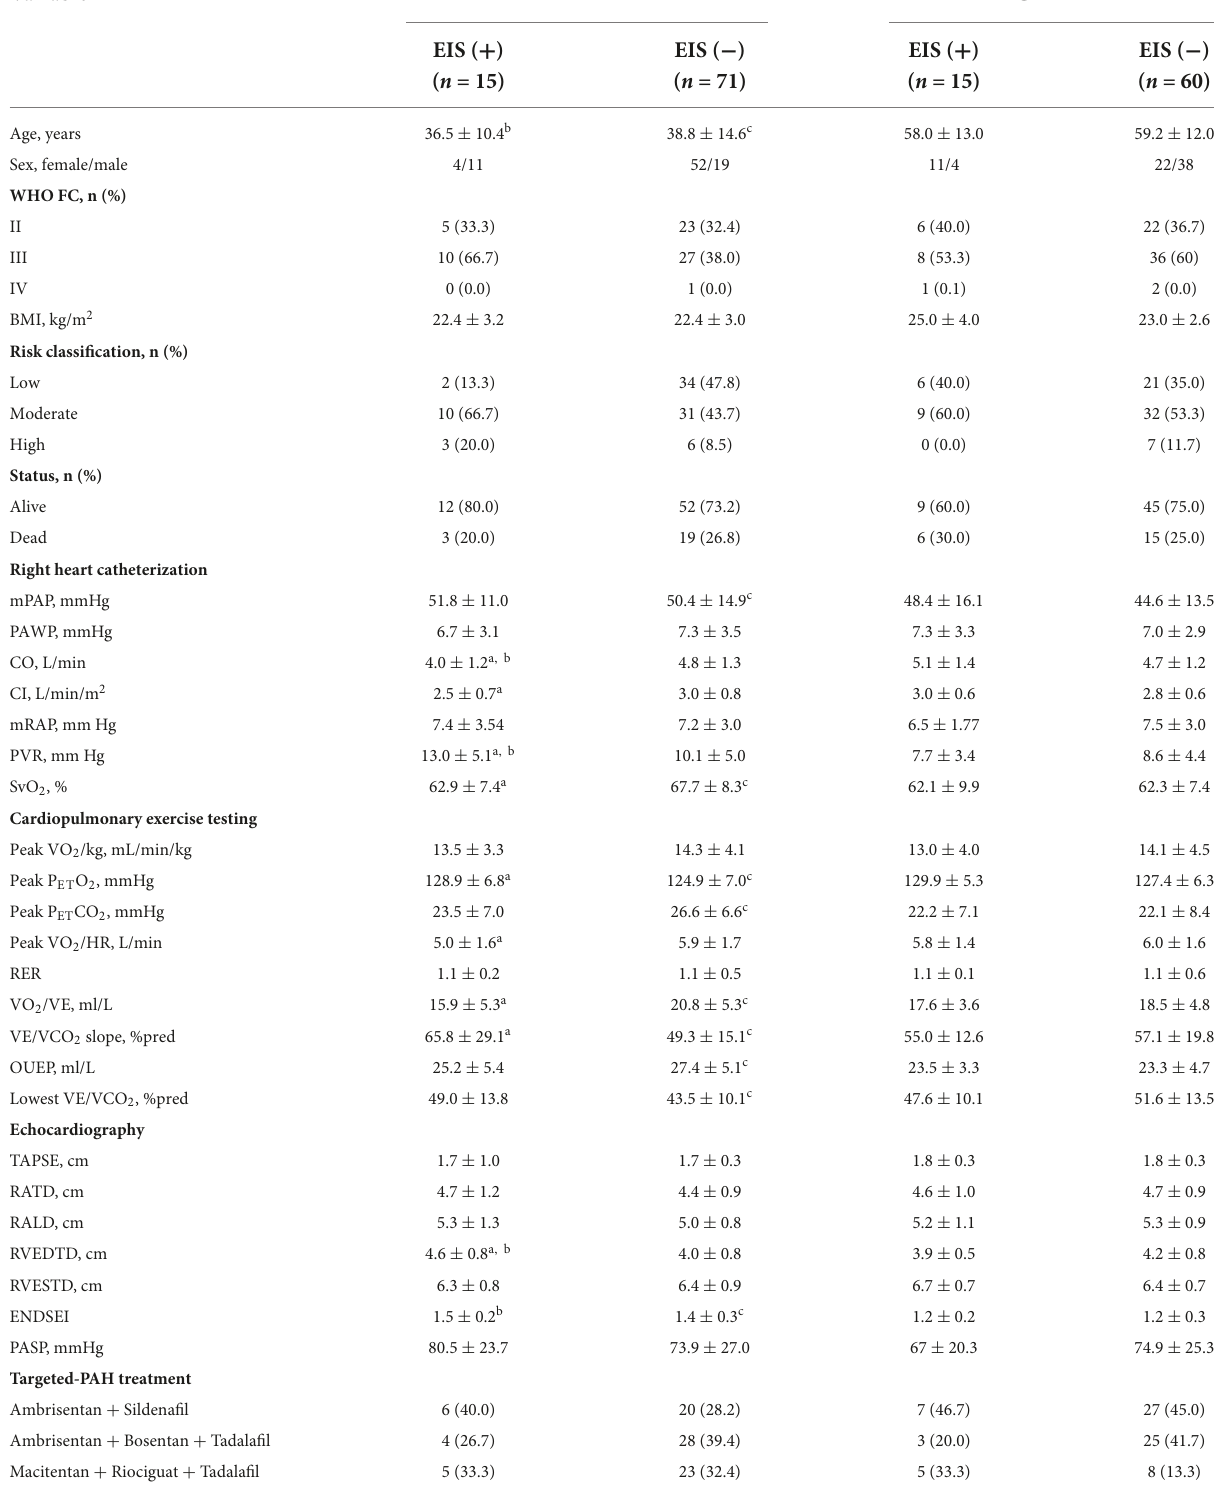
TABLE 2 Comparisons of demographic, hemodynamic, cardiopulmonary exercise testing, and echocardiographic variables in IPAH or CTEPH patients with vs. without EIS.